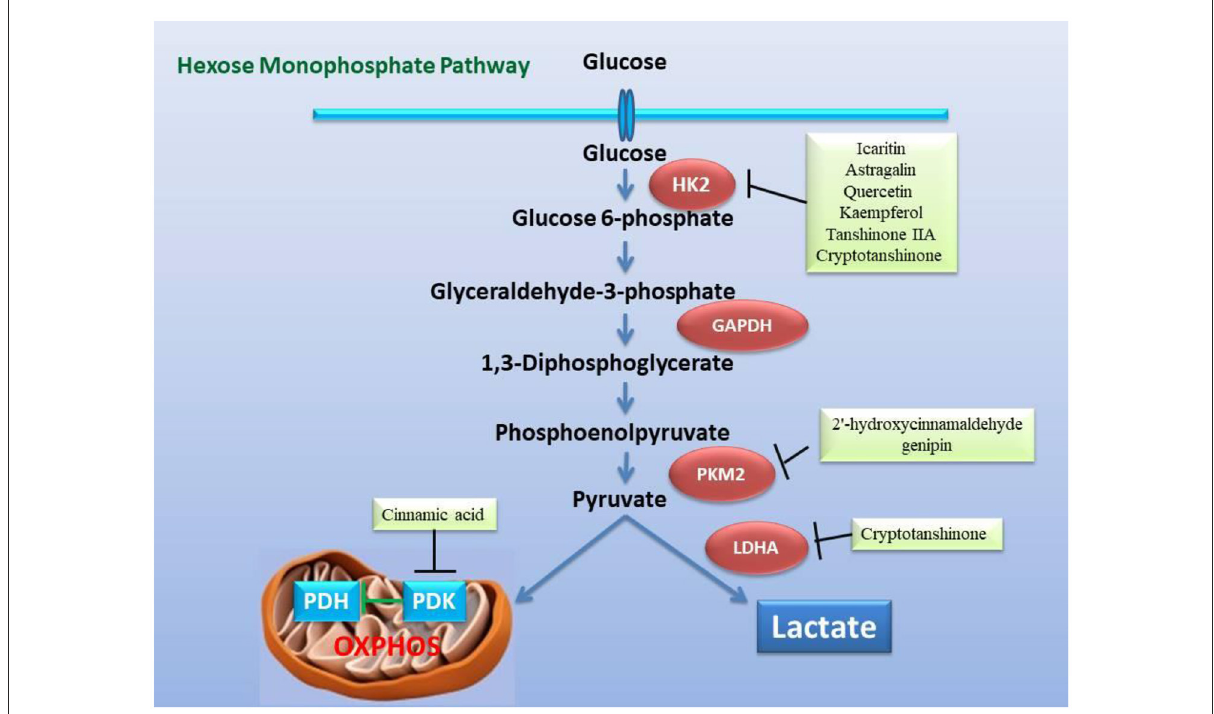
FIGURE4 Inhibitory effect of the active ingredients of the classic formulas of invigorating kidney on the key enzymes related to glycolysis in the mitochondrial hexose pathway caused by heart failure. The active ingredients in the classic formulas have inhibitory effects on the enzymatic activity or expression of HK2, PKM2, LDHA, and PDK,